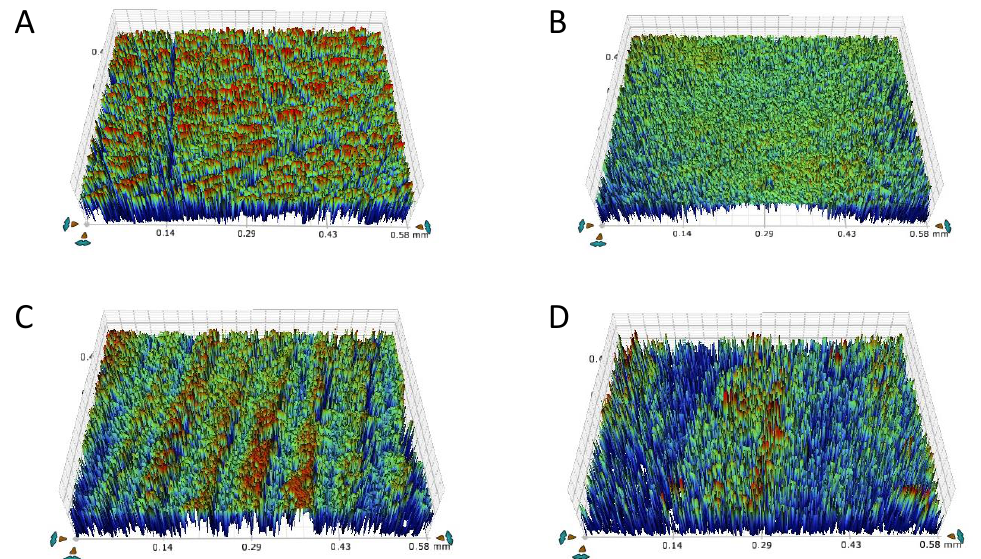
Figure 3. Images of surface roughness of specimens. ( A ) Milled, ( B ) horizontal, ( C ) vertical, and ( D )